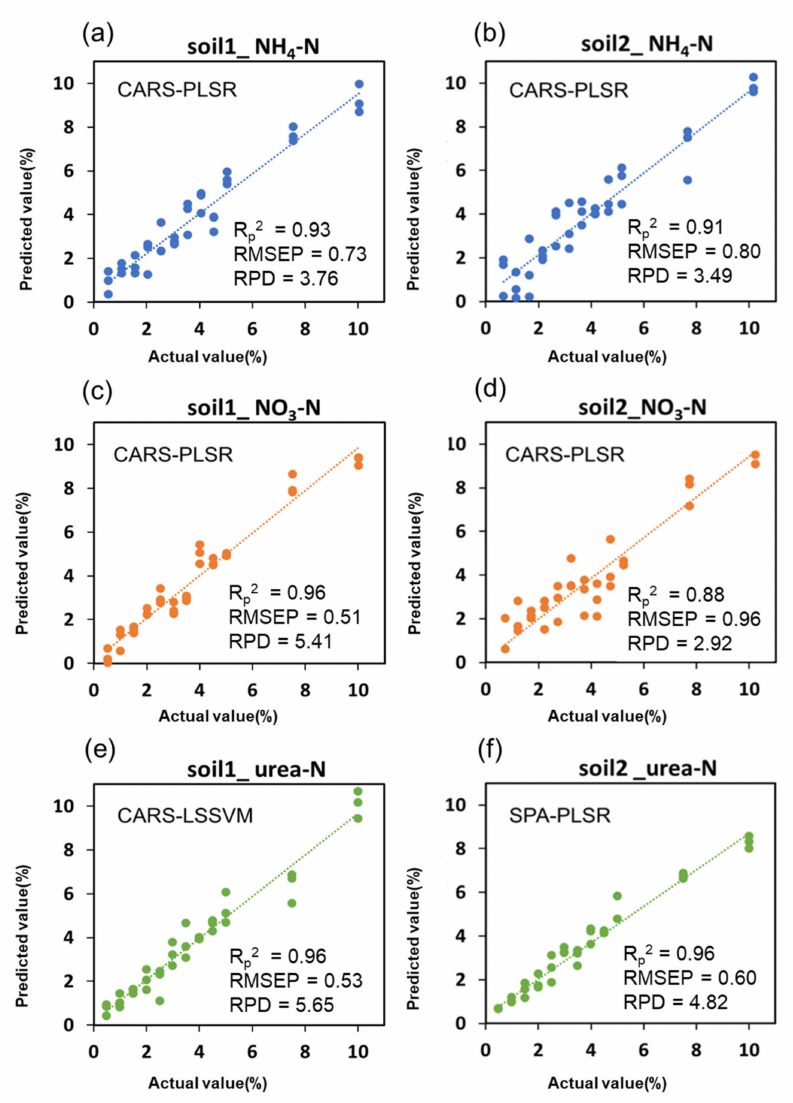
Figure 4. Plots of actual values versus predicted values of soil nitrogen content: ( a ) Soil1_NH 4 -N; ( b ) Soil2_NH 4 -N; ( c ) Soil1_NO 3 -N; ( d ) Soil2_NO 3 -N; ( e ) Soil1_urea-N; ( f )